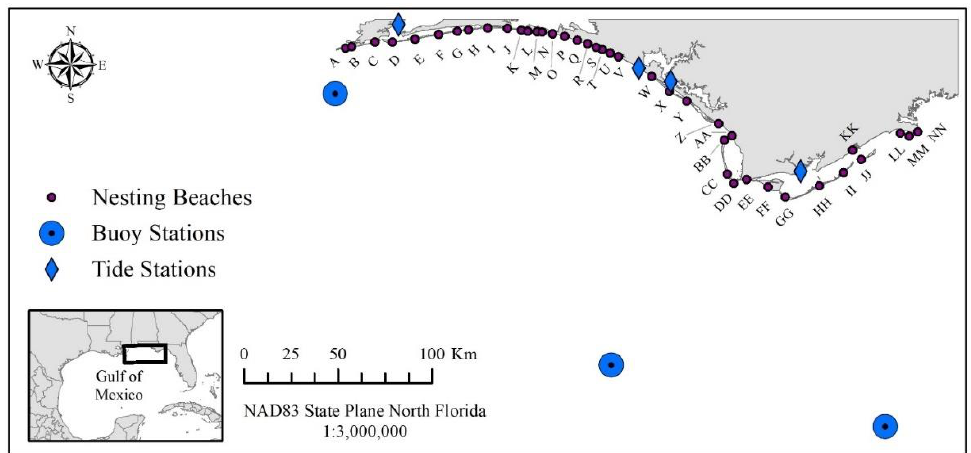
Figure 1. The Florida portion of the Northern Gulf of Mexico Loggerhead Recovery Unit, showing our study sites (A-NN). Data sourced from the Florida Fish and Wildlife Conservation Commis- sion Statewide Atlas of Sea Turtle Nesting Occurrence and Density. From west to east: A: Perdido